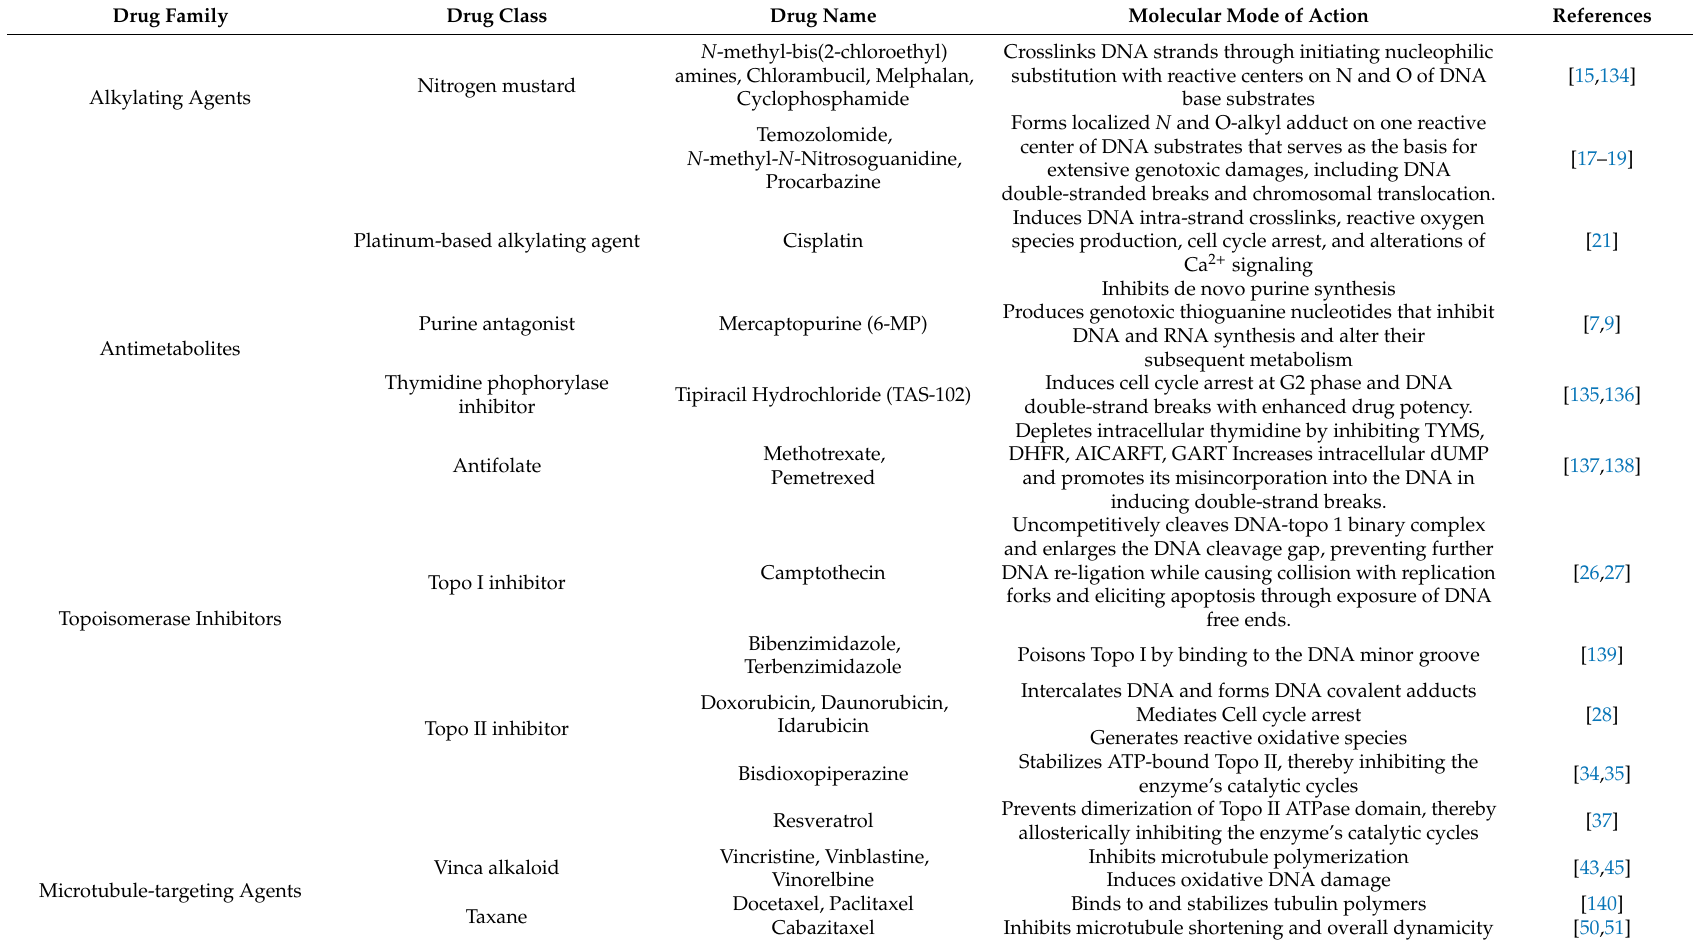
Table 1. Concise summary molecular modes of action of classical chemotherapeutic